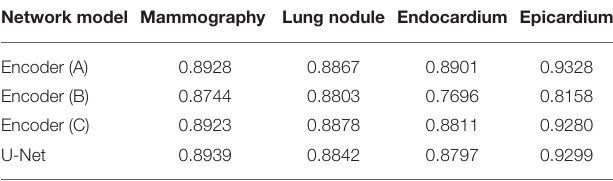
TABLE 1 | Experimental results of different kinds of encoders.